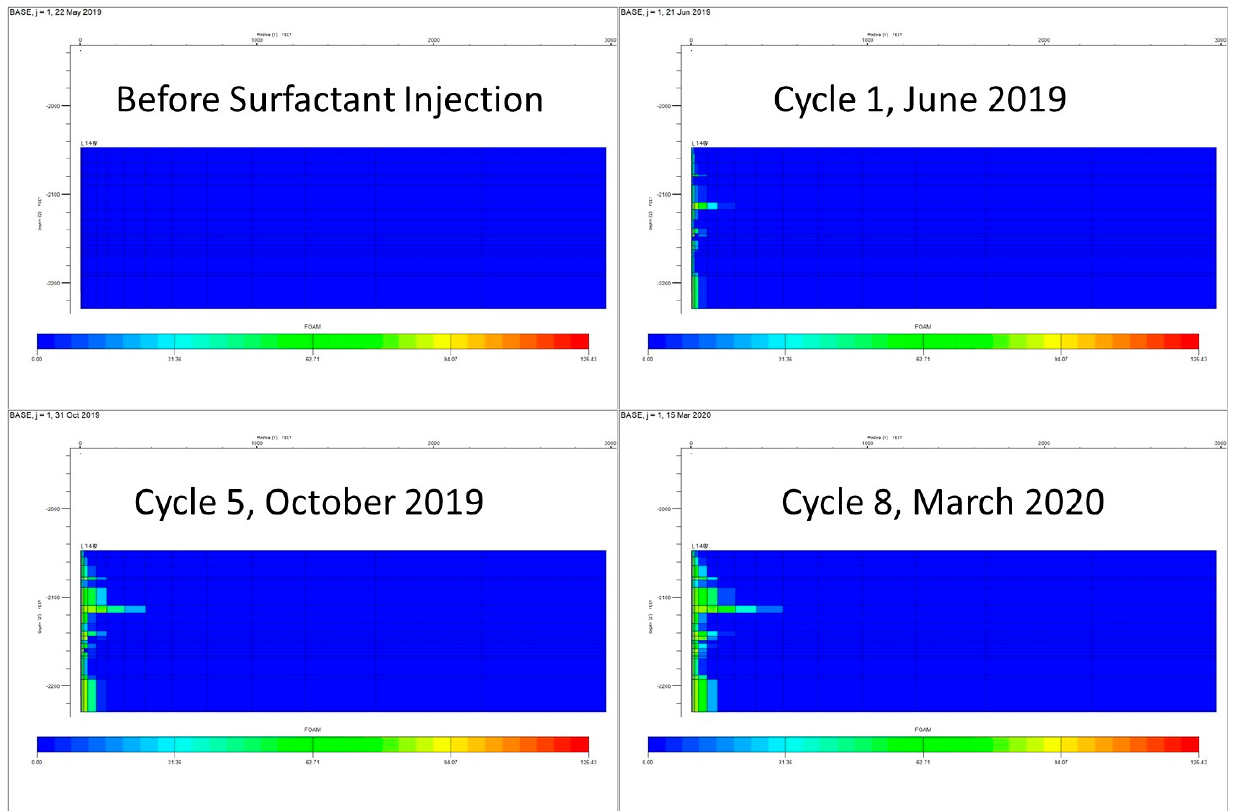
Figure 14. Cross-sectional (r-z) plot showing simulated foam concentrations for the weak foam case (FMMOB = 1.9) at the end of Cycles 1, 5 and 8.